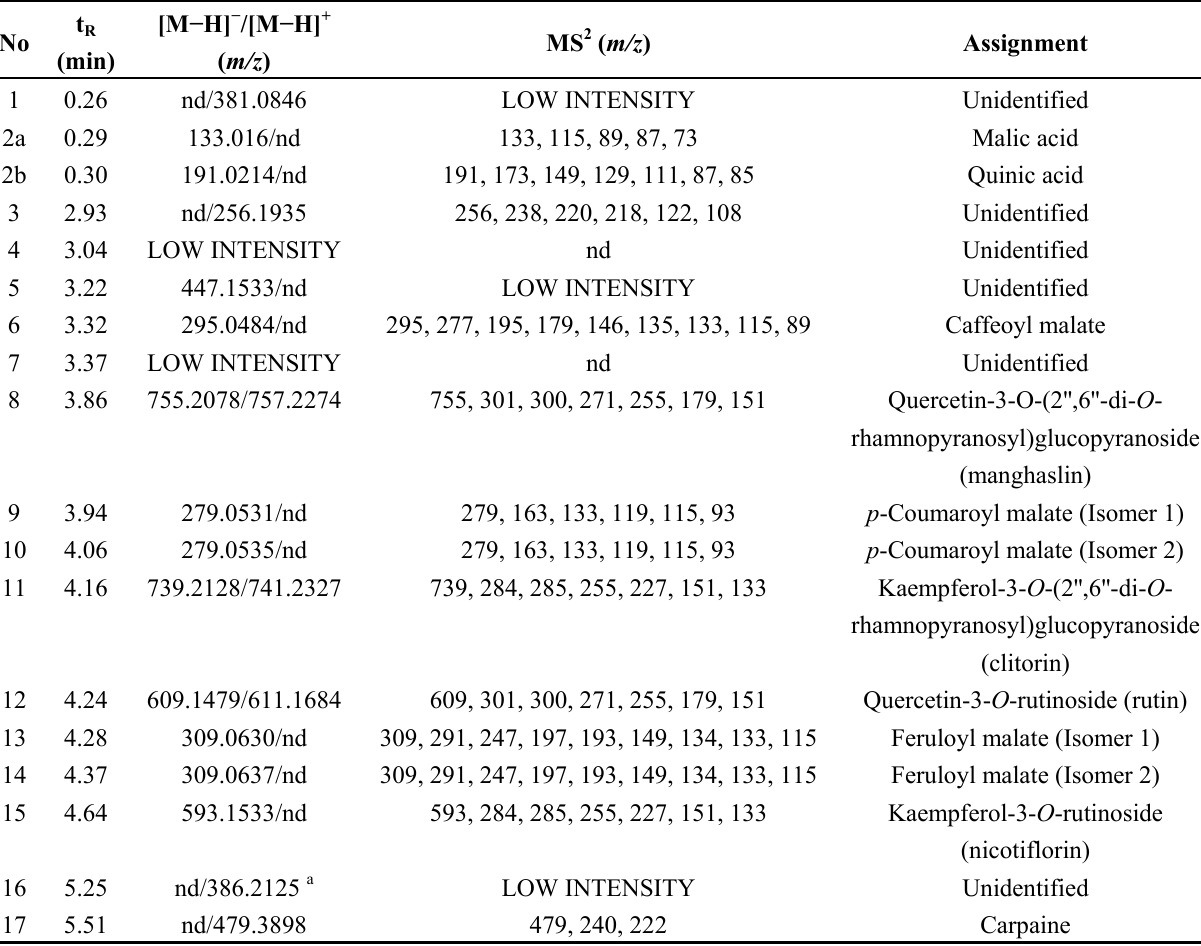
Table 1. Compounds identified in C. papaya leaf